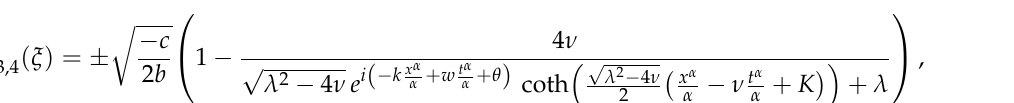
Figure 6. The first and second moments for the random solution ˜ sq and − 2 ≤ t , x ≤ 2, the first moment is on the upper part and the second moment is on the lower part. Case 2. At λ 2 − 4 ν < 0, ν (cid:54) = 0, ( ξ ) = ± ˜ sq 3,4 where α is a beta random distribution. The mean value E [ ˜ sq